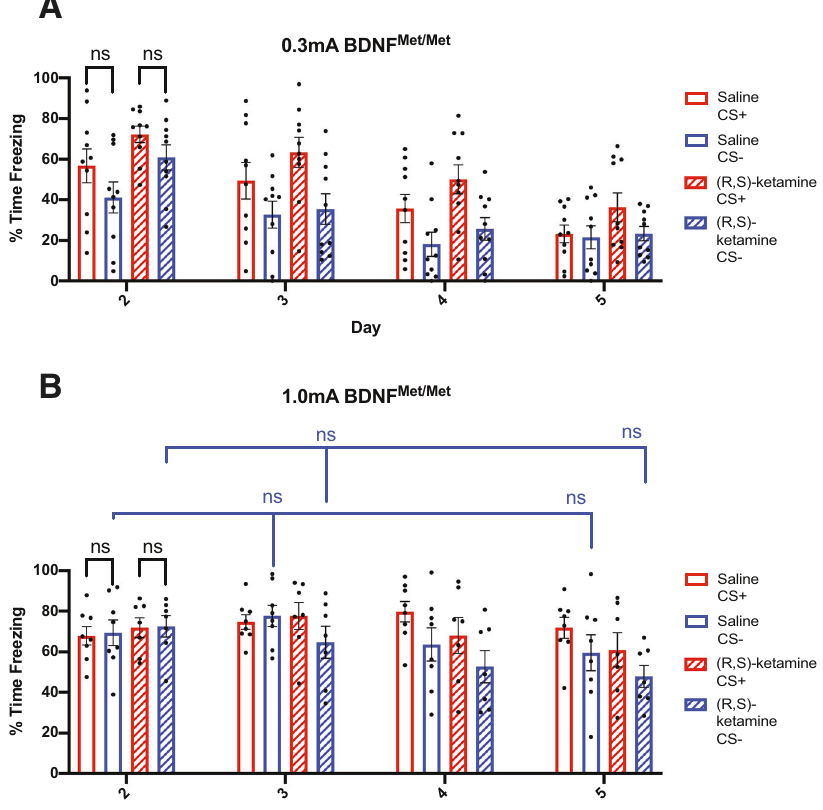
Fig. 3 The protective effects of prophylactic (R,S)-ketamine administration on fear generalization are impaired in BDNF Met/Met mice. A BDNF Met/Met mice injected with saline and conditioned with weak shocks ( N = 10) generalize and display similar levels of freezing behavior in response to the CS + and CS − tones during the Day 2 fear recall test session, and prophylactic (R,S)-ketamine administration prior to weak shock conditioning does not signi fi cantly alter fear discrimination in BDNF Met/Met mice ( N = 10). B BDNF Met/Met mice injected with saline and conditioned with strong shocks ( N = 8) generalize and freeze at similar levels to the CS + and CS − tones during the Day 2 fear recall test session and do not show reductions in freezing to the CS − tone across testing. BDNF Met/Met mice injected with prophylactic (R,S)-ketamine and conditioned with strong shocks ( N = 7) freeze at similar levels to the CS + and CS − tones during the Day 2 fear recall test session and do not show reduced freezing to the CS − tone across the other testing days. Error bars represent mean ± SEM. Three-way RM ANOVA with post hoc Tukey HSD tests, ns = p >